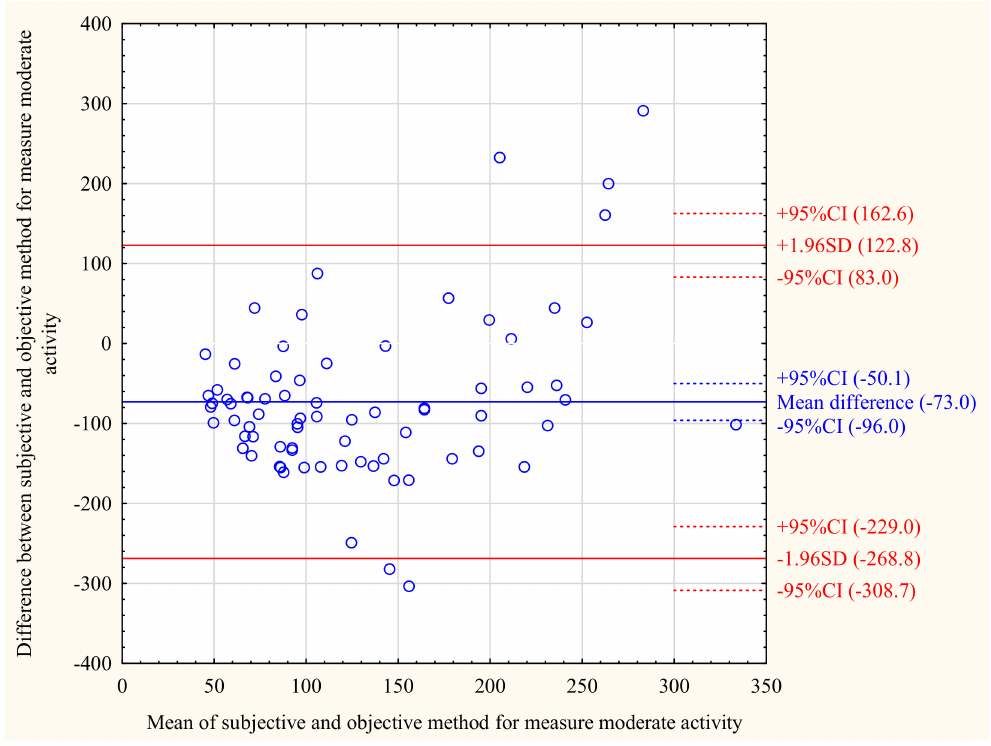
Figure 2. Bland–Altman plot for moderate activity [min/day] measured by the IPAQ and ActiGraph in total study population ( n =